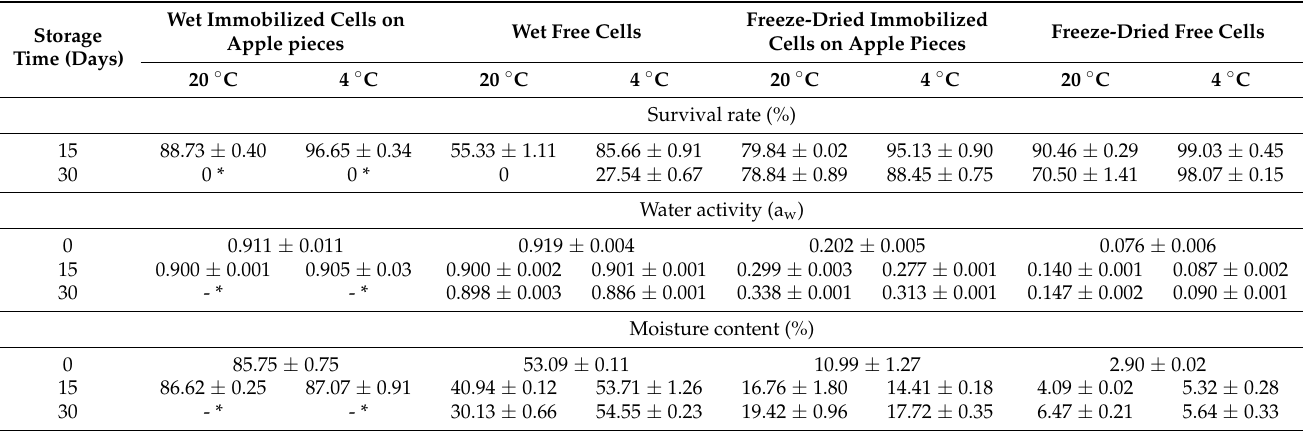
Table 1. Survival rate (%), water activity (a w ) and moisture content (%) of freeze-dried free and immobilized L. rhamnosus OLXAL-1 cells after short-term storage. Freeze-Dried Immobilized Wet Free Cells Freeze-Dried Free Cells on Apple Pieces